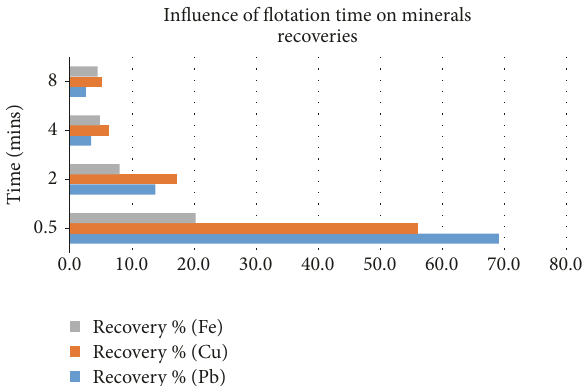
Figure 12: Influence of flotation time on flotation recoveries of galena, pyrite, and chalcopyrite at a chitosan’s dosage of 50